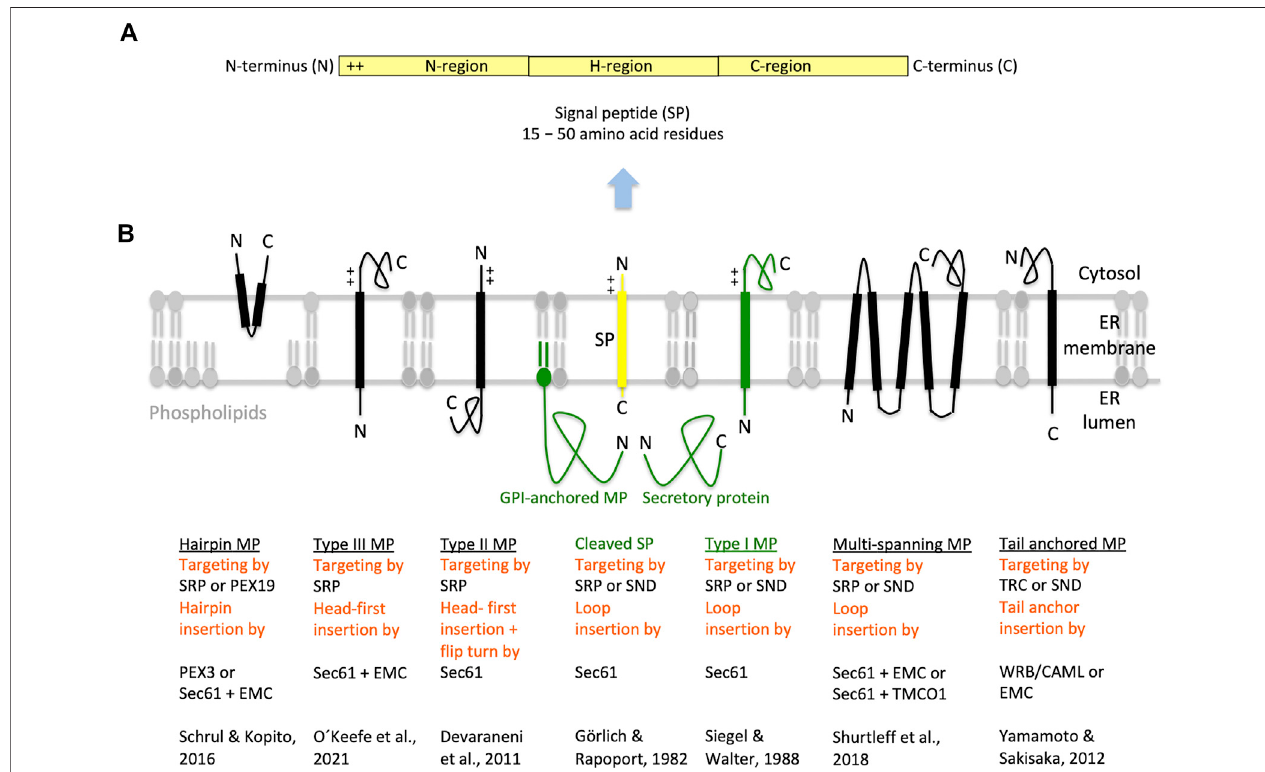
FIGURE 3 | Types of ER membrane proteins and their biogenesis. (A,B) The cartoons depict a signal peptide (SP) and six classes of ER membrane proteins (MP, underlined)withtheirparticularmembrane proteintypeandtherespectivemechanismofERtargetingandmembraneinsertion(bothindicatedbelowthecartooninred). Cleavable SPs (in yellow) have a tripartite structure and facilitate ER import of secretory proteins (in green), glycosylphosphatidylinositol (GPI)-anchored- and single- spanning type I membrane proteins (in green). In addition, they may mediate ER import of certain multi-spanning membrane proteins, but not of hairpin, single- spanning type II or III, other multi-spanning and TA membrane proteins, which depend on transmembrane helices (TMHs) that serve as SPs and facilitate membrane targeting as well as insertion. Positively charged amino acid residues (+) play an important role in the orientation of membrane proteins and SPs in the membrane; typically, the orientation follows the positive inside rule. In the case of membrane proteins with amino-terminal TMHs, membrane insertion typically involves the same components and mechanisms, which deliver secretory proteins and GPI-anchored membrane proteins to the ER lumen. In certain cases, however, auxiliary membrane protein insertases, such as EMC or TMCO1 complex may be involved. Following their ER import, GPI-anchored membrane proteins become membrane anchored via their carboxy-termini by GPI-attachment. Some key references are given. The Figure and Figure legend were adapted from Sicking et al. (2021a). C, carboxy-terminus; N,